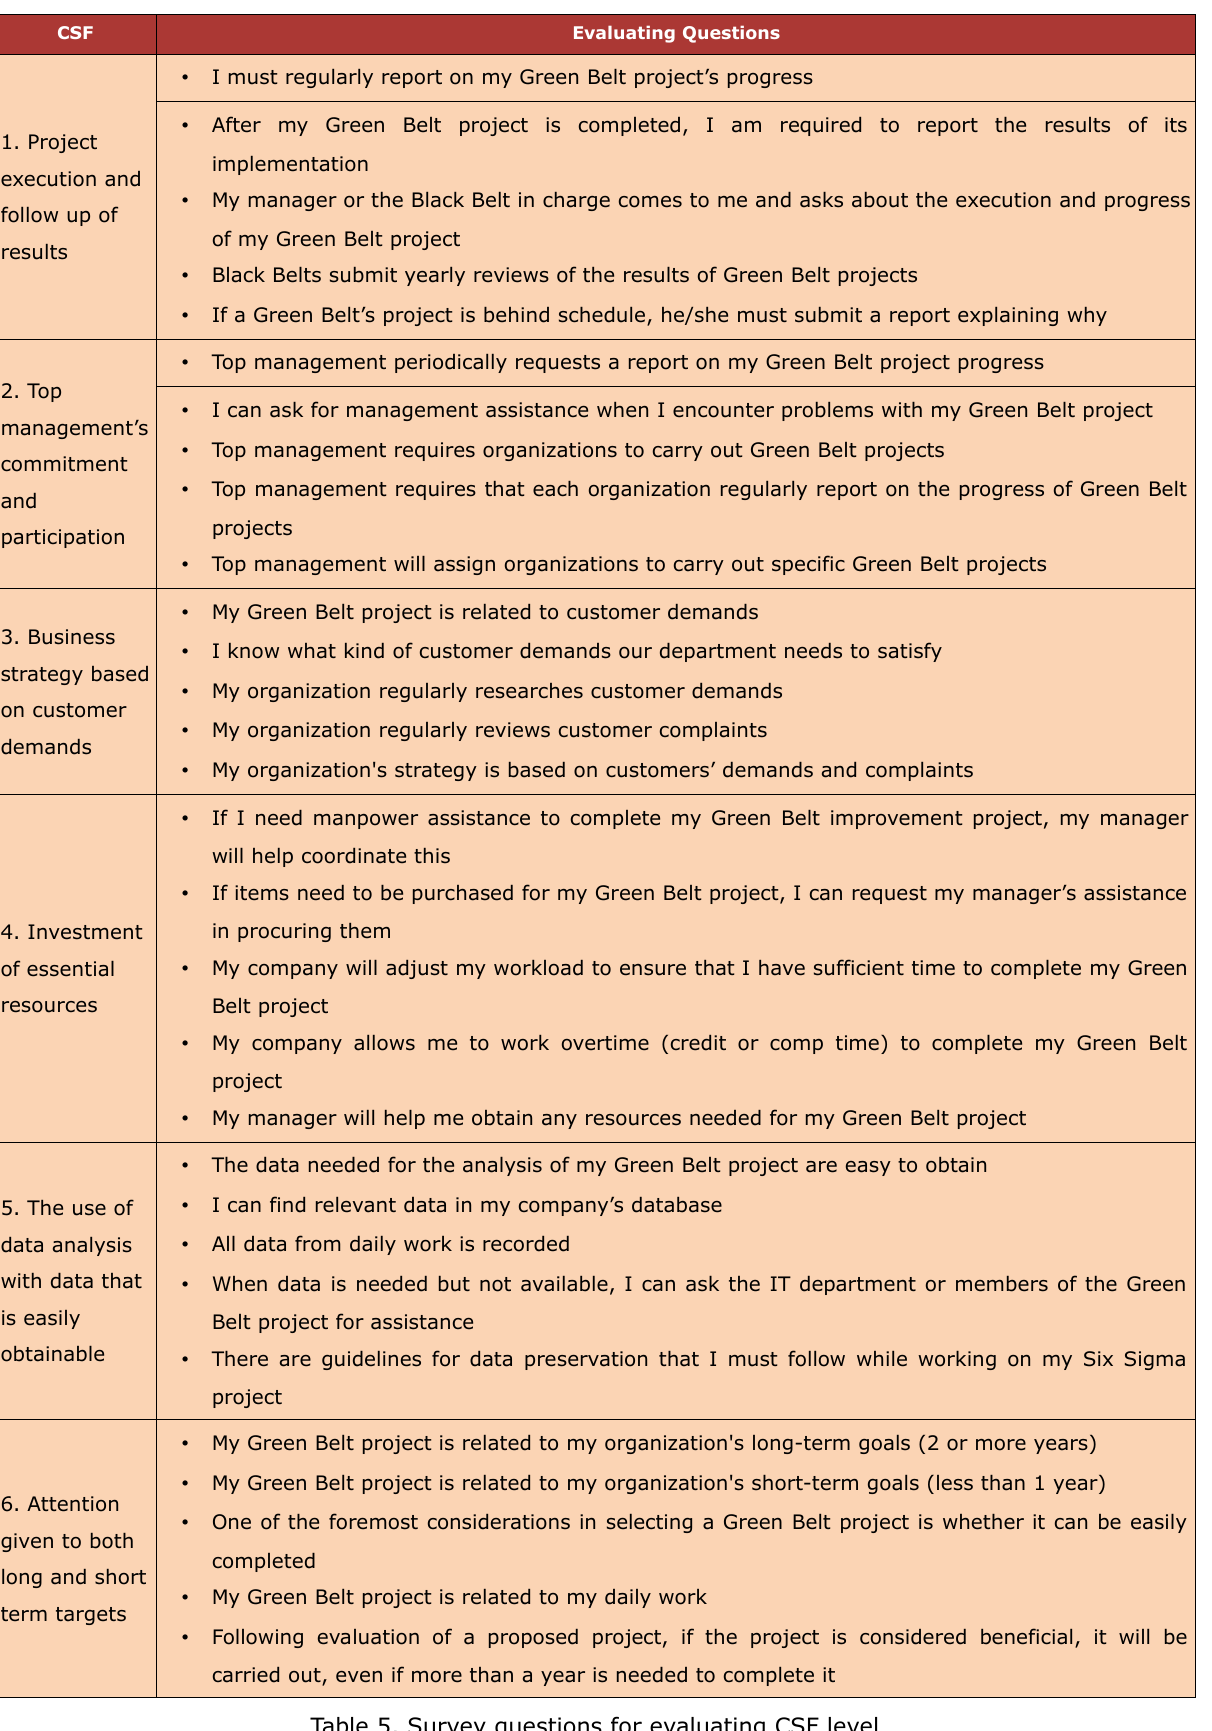
Table 5. Survey questions for evaluating CSF